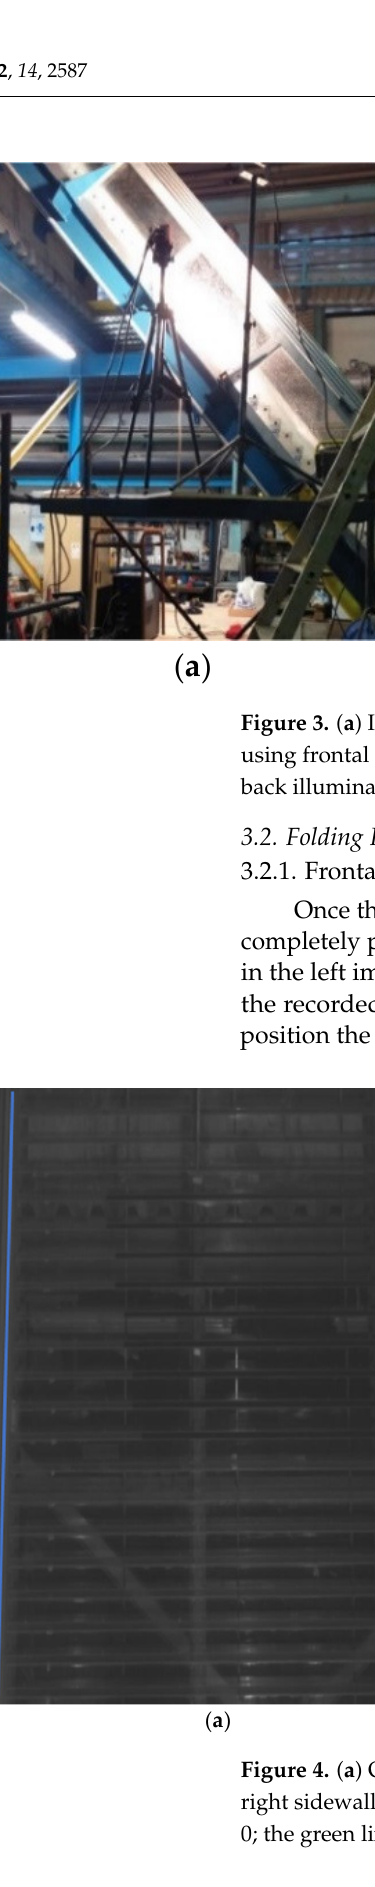
( c ) Figure 4. ( a ) Original frame #0001 of video 0 (without water, 200 fps); the blue line is the foot of the right sidewall of the chute. ( b ) Image folding (profile view). ( c ) Folded original frame #0001 of video 0; the green line represents the foot of the folded right sidewall of the chute.